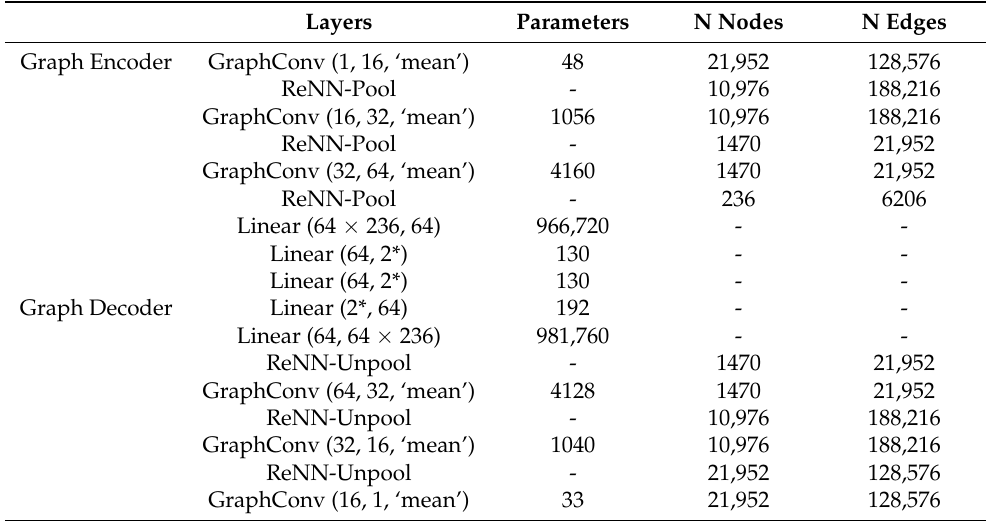
Table A1. ReNN Graph VAE used for the Water + Slab dataset. For the Water dataset, the same architecture was used but the parameter marked with an asterisk was changed to 1, in accordance with the latent space dimensionality.